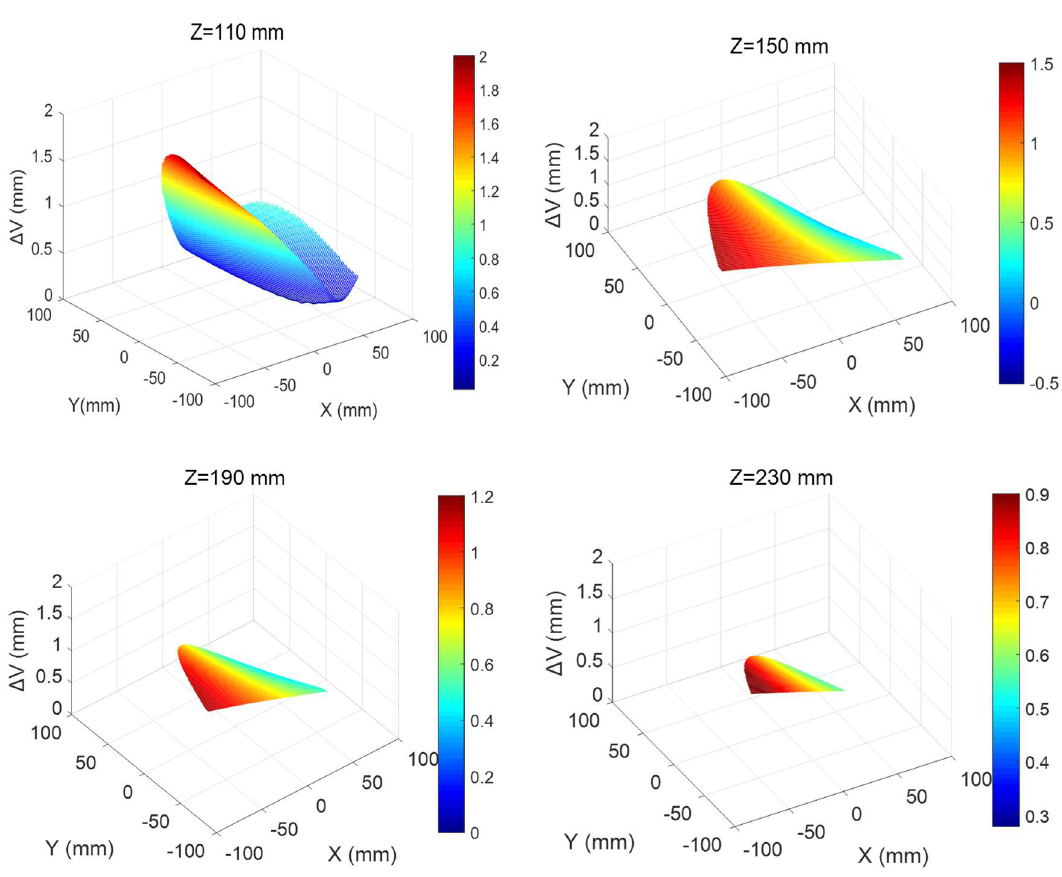
Figure 6. The workspace of the CDPR for 3D Printing.